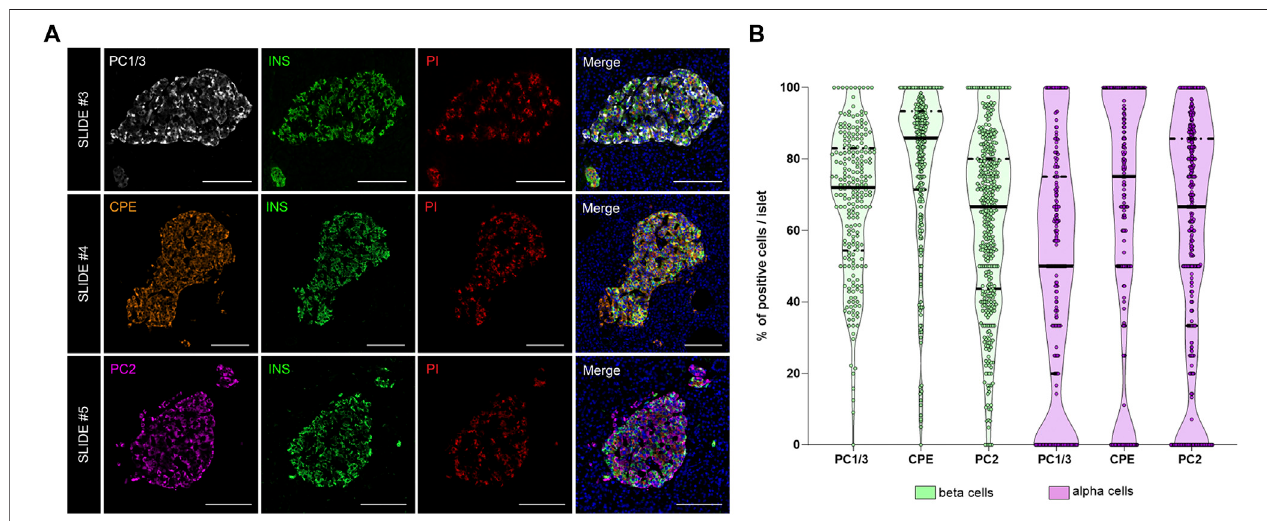
FIGURE5| Analysisoftheprohormone processing enzymes PC1/3,CPEand PC2intheendocrinepancreas. (A) Representativeimagesshowingthedistribution and localization of the proinsulin processing enzymes PC1/3 (slide #3, upper row), CPE (slide #4, middle row) and PC2 (slide #5, lower row) in the islets. (B) Violin plots showing the proportion of PC1/3+, PC2+, and CPE+ cells in beta (green) and alpha cells (violet). Each dot represents an islet. Scale bar: 100 μ m.